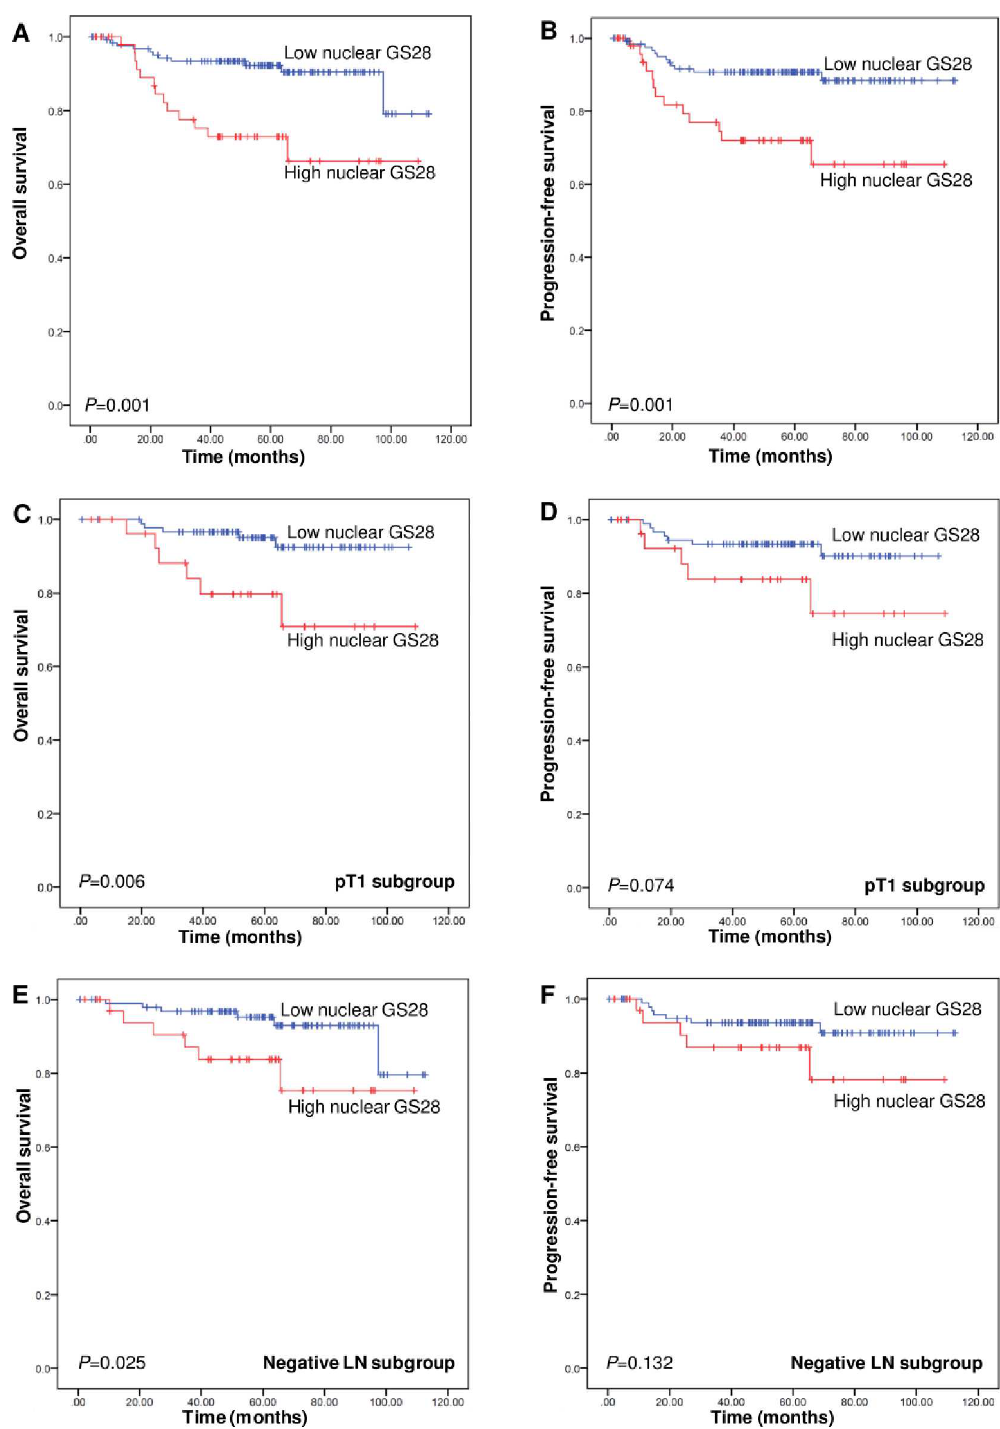
Fig 2. Kaplan-Meier curvesof univariate analysisdata (log-rank test). (A) The overall survival(OS)and (B) progression-free survival(PFS) of cervical cancer patientswith high versus low nuclear expression of GS28. (C) The OS and (D) PFS of patientswith stage T1 tumors(pT1 subgroup), and (E) the OS and (F) PFS of patients withoutlymph node metastasis(negative-lymph node-metastasis subgroup) with high versus low nuclear expression of